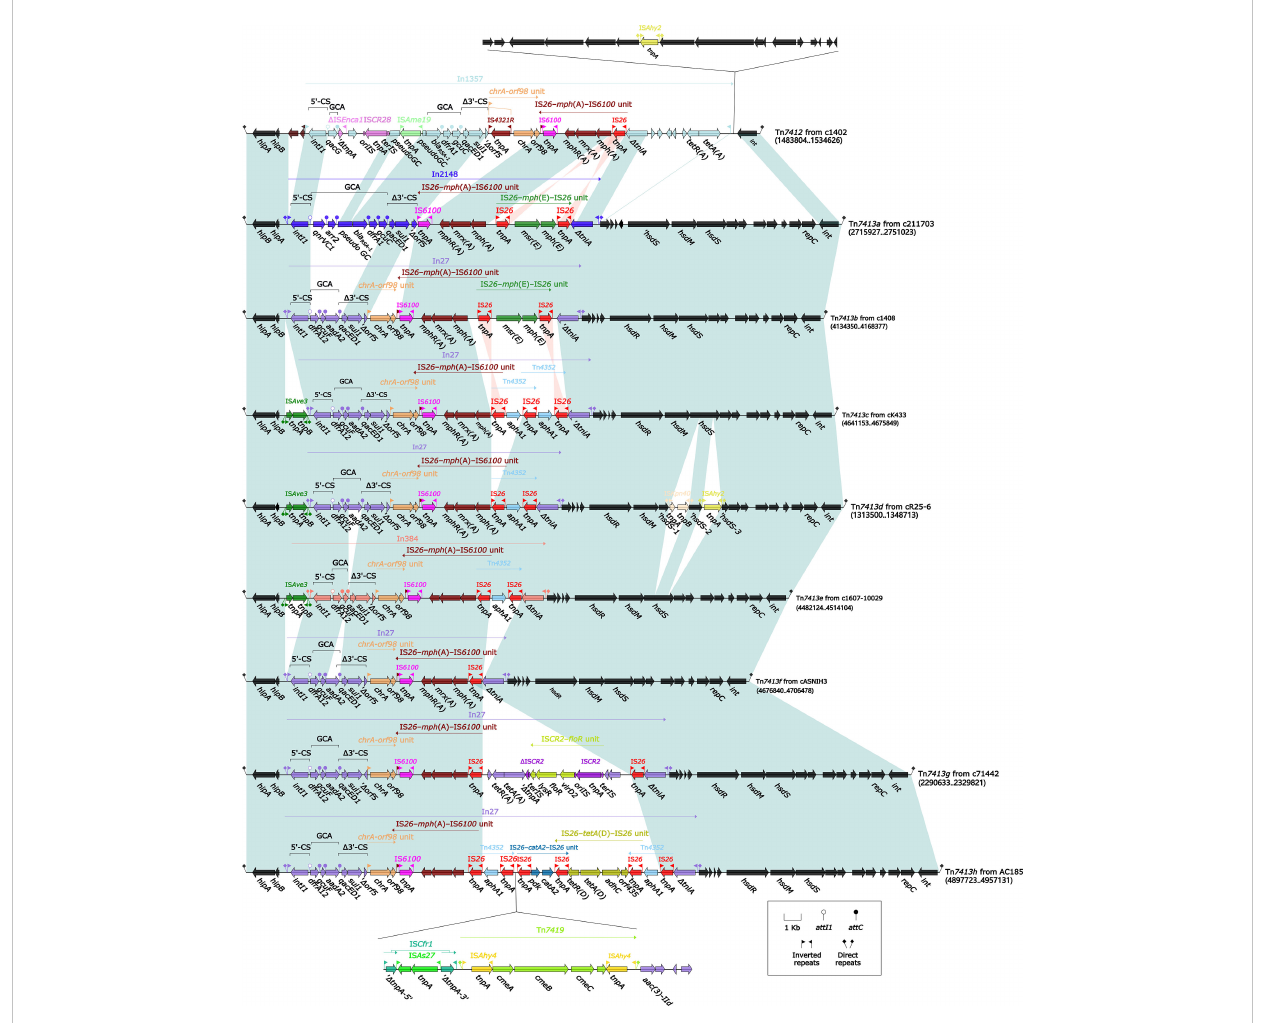
FIGURE 2 Comparison of Tn 7413a with related IMEs. Genes were denoted by arrows. Genes, mobile genetic elements, and other features were colored based on their functional classi fi cation. Shading denoted regions of homology (nucleotide identity > 95%). A single quotation mark in front of the gene name indicated